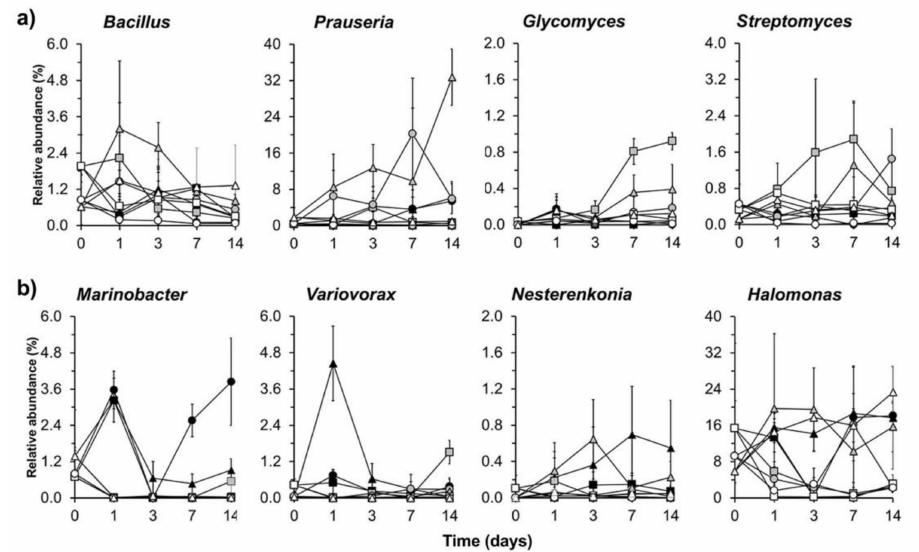
Figure 7. ( a ) Changes in the relative abundance (%) of bacterial genera with higher relative abundance in NDF amended soil than in the unamended soil incubated aerobically at 22 ± 2 ◦ C for 14 days. Unamended soil with EC 1.9 dS m − 1 ( (cid:3) ), unamended soil with EC 17.3 dS m − 1 ( ∆ ), unamended soil with EC 33.4 dS m − 1 ( ), neutral detergent fibre fraction (cid:35) amended soil with EC 1.9 dS m − 1 ( (cid:4) ), neutral detergent fibre fraction amended soil with EC 17.3 dS m − 1 ( (cid:78) ), neutral detergent fibre fraction amended soil with EC 33.4 dS m − 1 ( • ), young maize plants amended soil with EC 1.9 dS m − 1